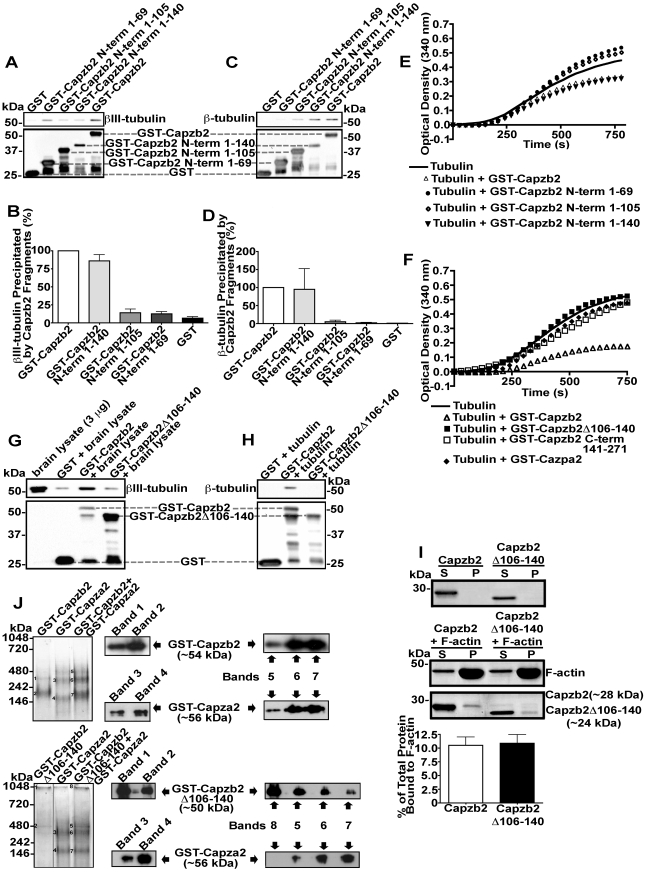
Identification of the Capzb2 region necessary for binding tubulin and for the effect on tubulin polymerization.(A–D) Specific GST-tagged Capzb2 protein segments show differential ability to pull down βIII-tubulin from mouse brain lysates (A and B) or to bind β-tubulin in vitro (C and D). The average ratio (n = 3) between the signal for the GST-tagged Capzb2 full-length/protein segment and the βIII-tubulin signal obtained in pull-down assays from brain lysates (C) or the β-tubulin signal in in vitro binding assays (D) is shown. Note that GST-tagged full-length Capzb2 and GST-tagged Capzb2 N-terminus 1–140 show a strong affinity for β-tubulin, whereas smaller GST-Capzb2 fragments (N-terminus 1–105 and N-terminus 1–69) showed progressively weaker affinities for β-tubulin in vitro; GST-tag alone serves as a negative control. (E) Tubulin polymerization assay was performed as in Figure 4D, in the presence of 10 µM GST-Capzb2, or one of three progressively shorter GST-Capzb2 N-terminus segments. Similar to GST-Capzb2, GST-Capzb2 N-terminus 1–140 decreased the rate and extent of polymerization. However, GST-Capzb2 N-terminus 1–105 and GST-Capzb2 N-terminus 1–69 did not have a negative effect on tubulin polymerization. (F) Tubulin polymerization assay was performed as in Figures 4D and 5E, in the presence of 10 µM GST-Capzb2, 10 µM GST-Capzb2Δ106–140, 10 µM GST-Capzb2 C-terminus 141–271, or 10 µM GST-Capza2. Capzb2 deletion mutant lacking region Δ106–140 did not have a negative effect on tubulin polymerization. In addition, neither Capzb2 C-terminus 141–271 nor the other CP unit, Capza2, affected tubulin polymerization, whereas Capzb2 decreased both the rate and the extent of polymerization. (G and H) When compared with GST-Capzb2, GST-Capzb2Δ106–140 could not specifically precipitate βIII-tubulin from brain lysate (G) and was not able to bind β-tubulin in vitro (H); GST tag alone served as a negative control (G and H). (I) Capzb2 or Capzb2Δ106–140 were incubated alone or in the presence of F-actin. Upon centrifugation, both the supernatant (S) and pellet (P) of each reaction were analyzed by SDS-PAGE followed by Coomassie Brilliant Blue staining. A representative experiment of four performed is displayed. In the presence of F-actin, both Capzb2Δ106–140 and Capzb2 are comparably cosedimented with F-actin. Densitometry indicates that the percentage of Capzb2Δ106–140 (n = 7) and the percentage of Capzb2 (n = 8) bound to F-actin do not differ significantly (p = 0.69). (J) GST-Capzb2+GST-Capza2 and GST-Capzb2Δ106–140 (1 µM)+GST-Capza2 (1 µM) were incubated for 10 min at 4°C and subjected to native PAGE. Gels were analyzed with Denville Blue stain. Following destaining, the bands were excised and their content was extracted under alkaline conditions and subjected to Western blot analysis. Note that the GST-Capzb2Δ106–140 signal is weak due to the relatively lower affinity of this mutant for the Denville Blue stain in comparison to GST-Capza2. Thus, the GST-Capzb2Δ106–140 lane is overexposed. Western blot analysis indicates the identity of GST-Capzb2, GST-Capza2, and GST-Capzb2Δ106–140. When incubated with GST-Capza2, both GST-Capzb2 and GST-Capzb2Δ106–140 give rise to a similar profile of heterodimer complexes.